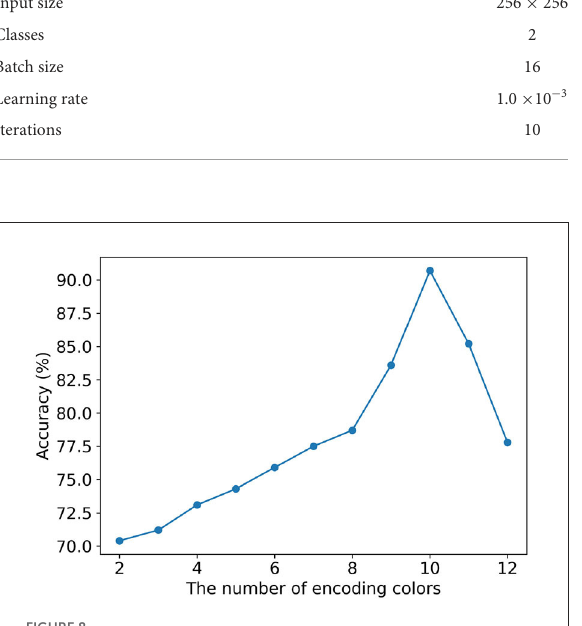
detection methods are proposed for the comparison